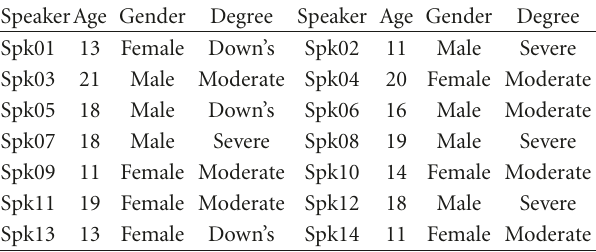
Table 1: Impaired speakers in the corpus (Down’s stands for Down’s Syndrome).